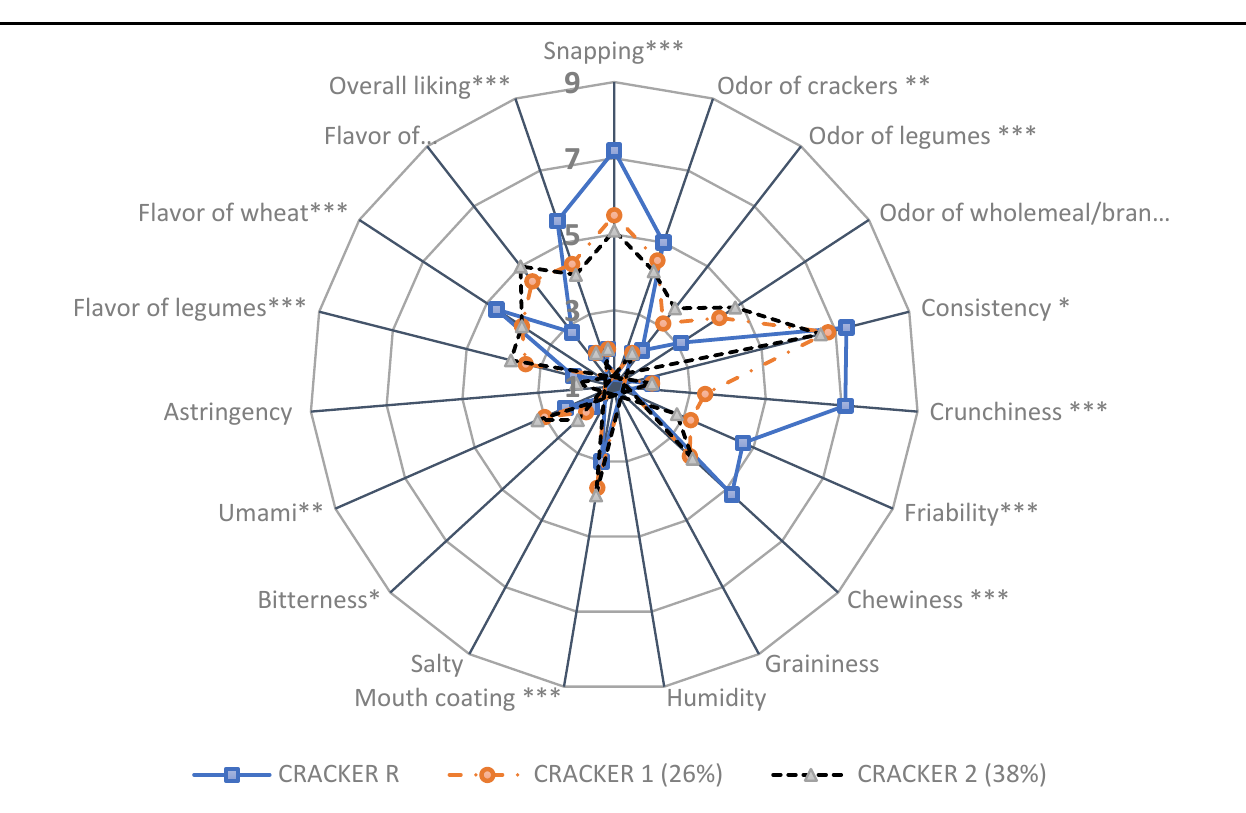
Figure 4. Sensorial profiles of crackers with [Cracker 1 (26%); Cracker 2 (38%)] and without [Cracker R] bean flour. Data analyzed by ANOVA and post hoc test (Tukey’s HSD); *, **, *** indicate significant differences between the tested products at p < 0.1, p < 0.5 and p < 0.01, respectively.